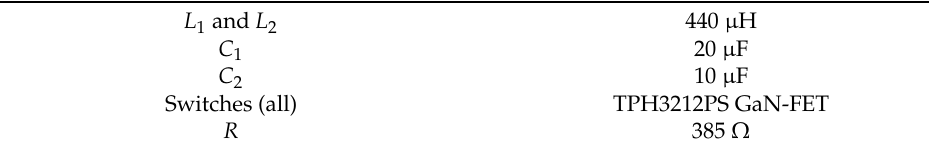
Table 1. Parameters of